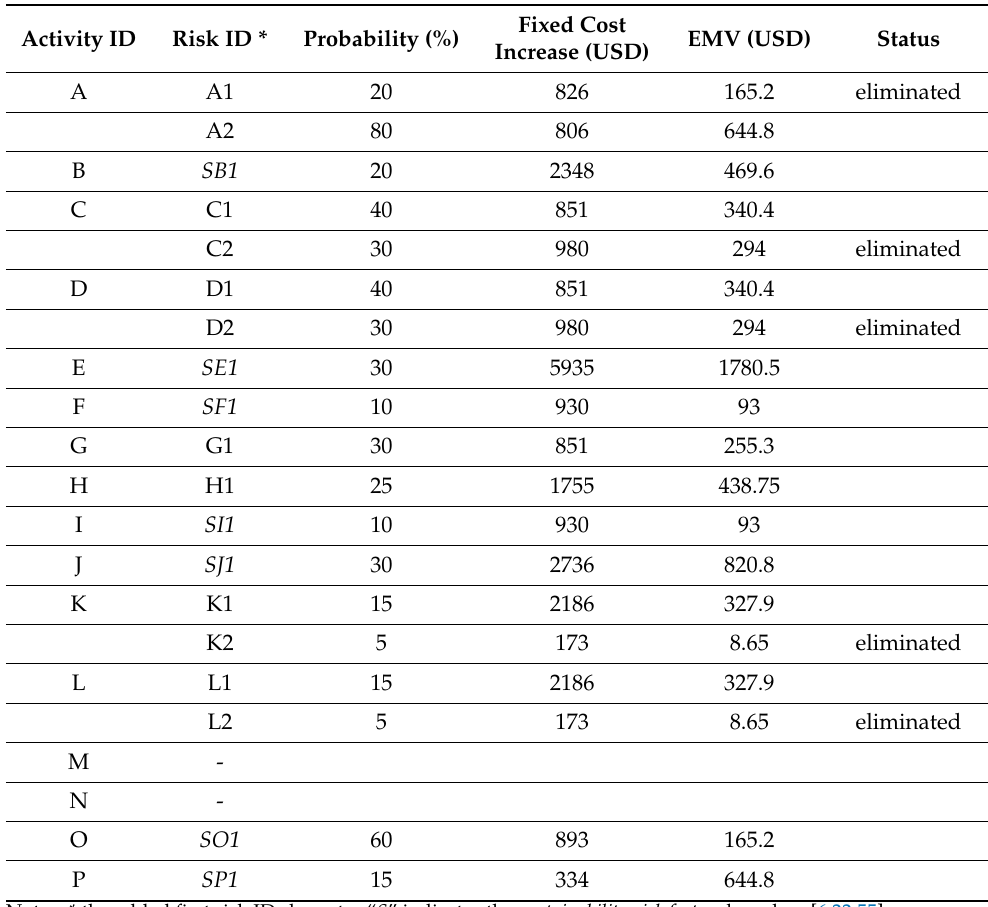
Table 8. The classification of critical risk